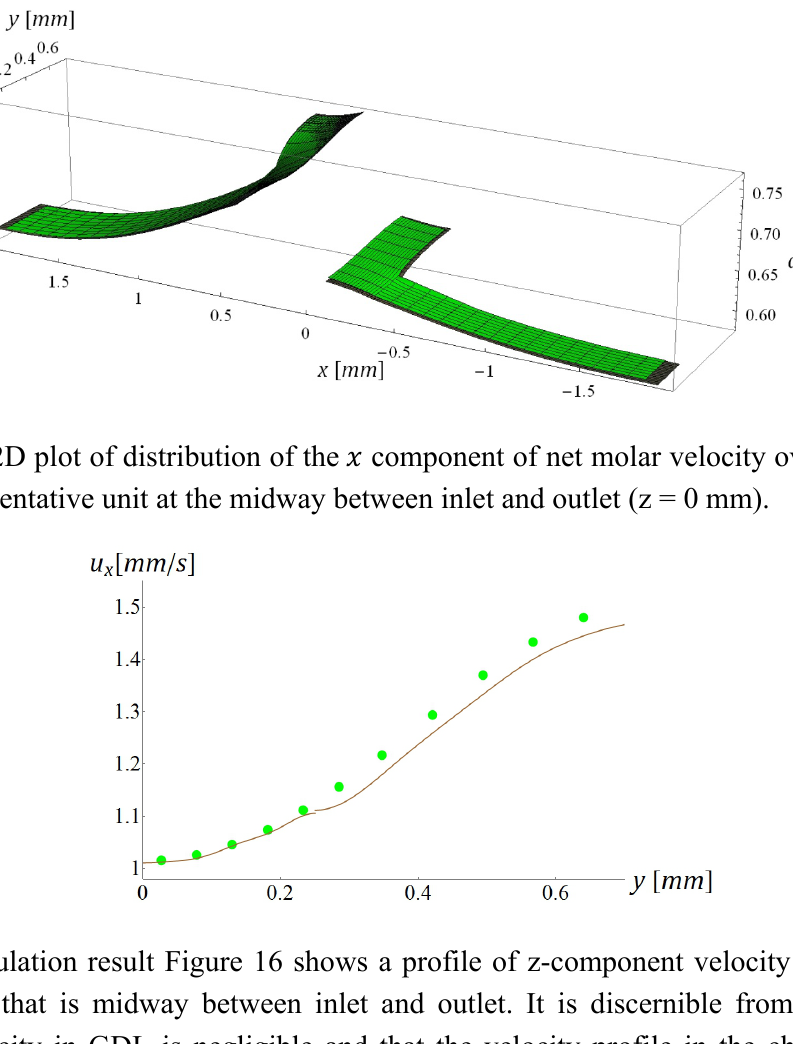
Figure 14. Relative humidity in the slice that is midway between inlet and outlet i.e. , z = 0. Green plot are CFD results and brown HAN-FC results.